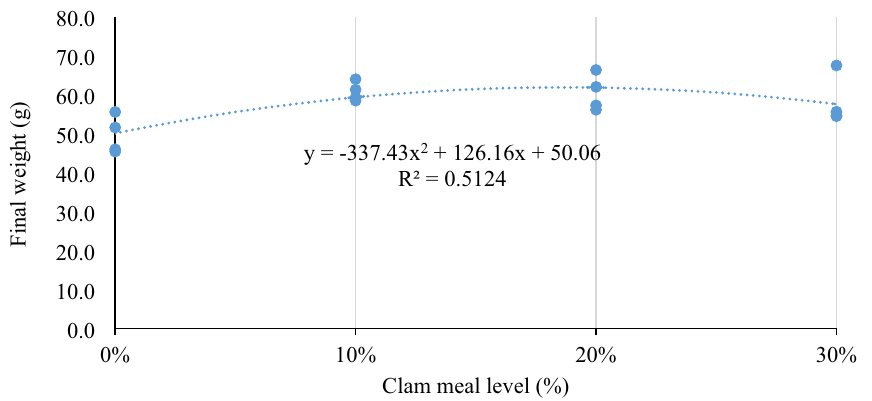
Figure 2. Second-degree polynomial regression analysis of final weight (FW) against dietary clam meal (CM) levels (0%, 10%, 20%, 30% CM of the dry diet) fed to juvenile Florida pompano for 12 weeks.